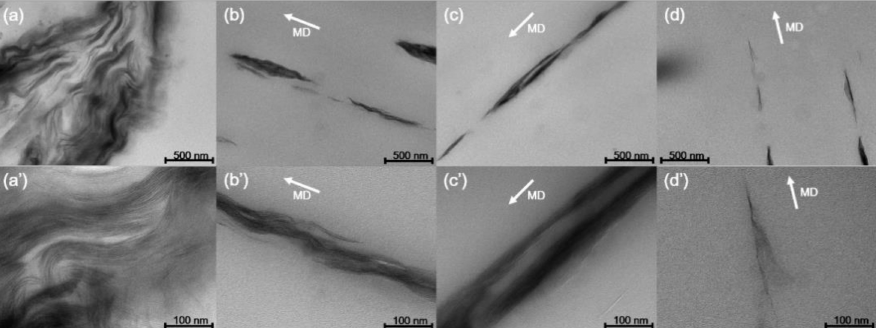
Figure 3. TEM images of PP/nanoclay nanocomposite containing 2.0 wt% nanoclay according to the draw ratio: ( a ), ( a’ ) × 1.0; ( b ), ( b’ ) × 9.0; ( c ), ( c’ ) × 13.5; ( d ), ( d’ ) ×